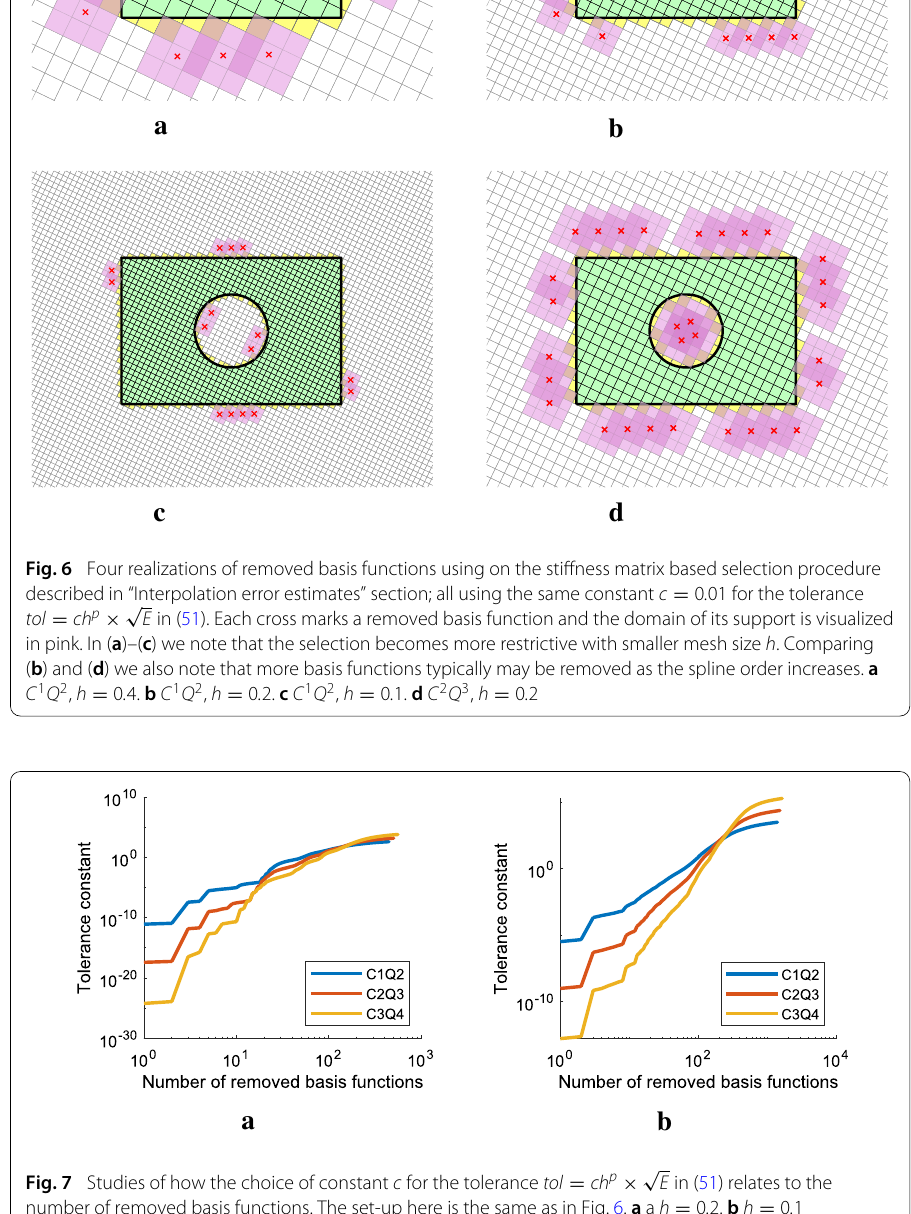
√ E in (51) relates to the